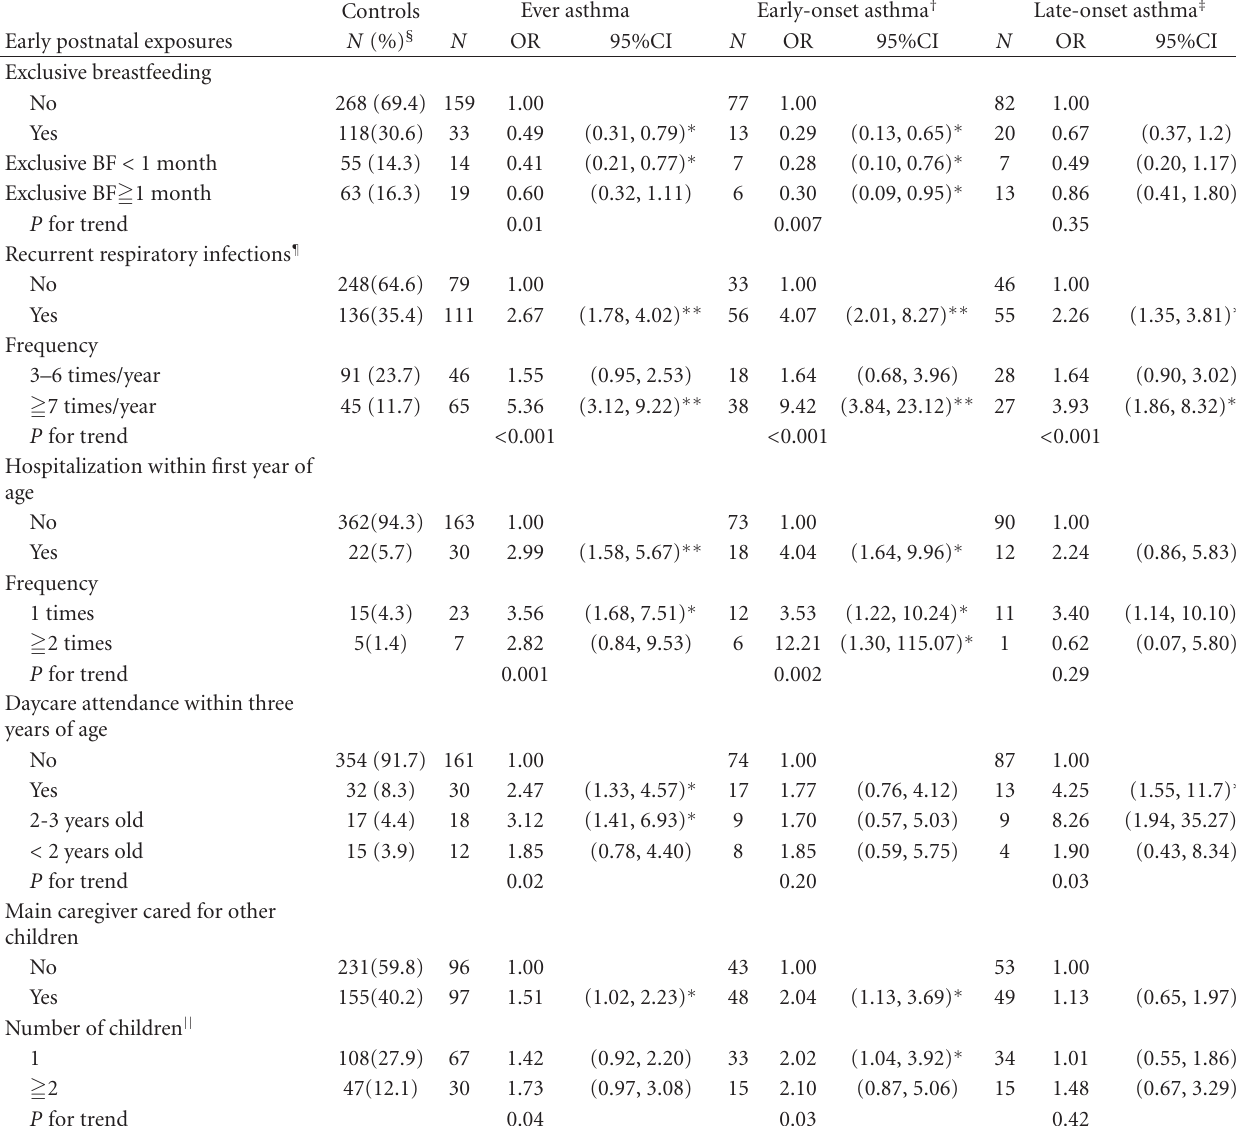
Table 4: Risks for childhood asthma in relation to early postnatal